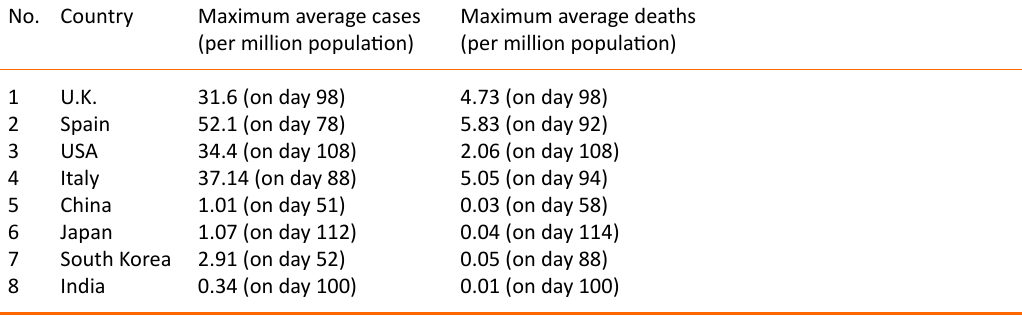
Table 4. Comparison of maximum average confirmed cases and deaths (per million population) of different countries No. Country